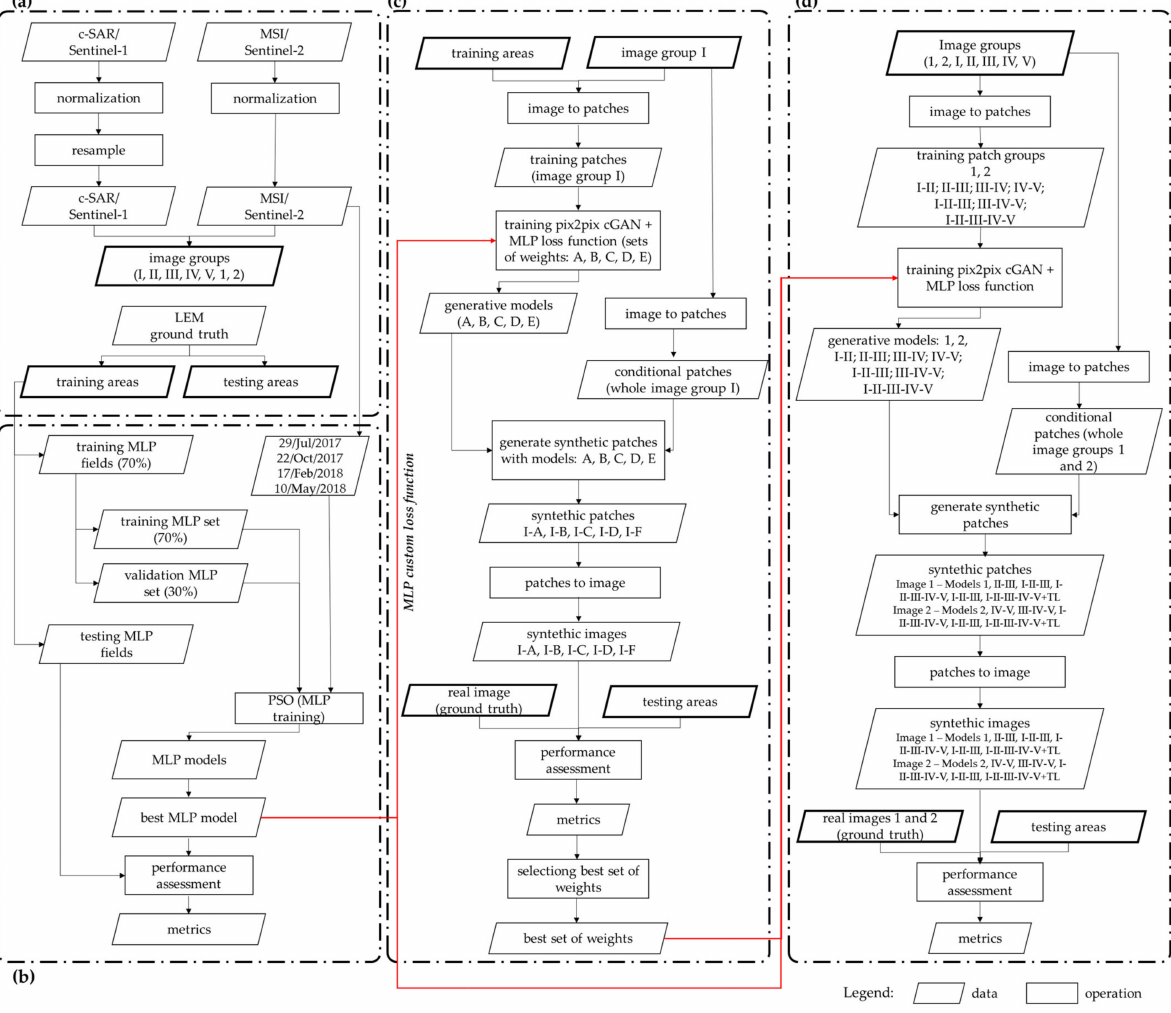
Figure 1. Flowchart with the main phases carried out in the study: ( a ) Dataset and satellite image pre- processing; ( b ) MLP hyper-parameter optimization; ( c ) Evaluation of the MLP custom loss function; and ( d ) Evaluation of the generative models